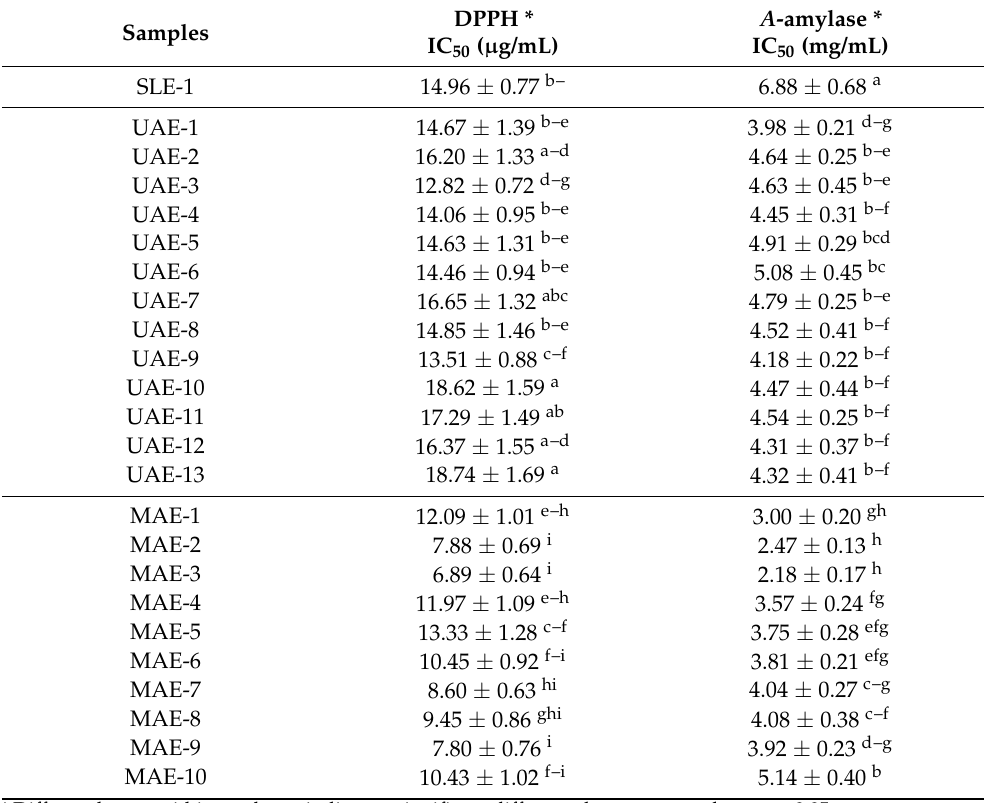
Table 4. Antioxidant activities and α -amylase inhibitory activities of black elderberry press-cake extracts.